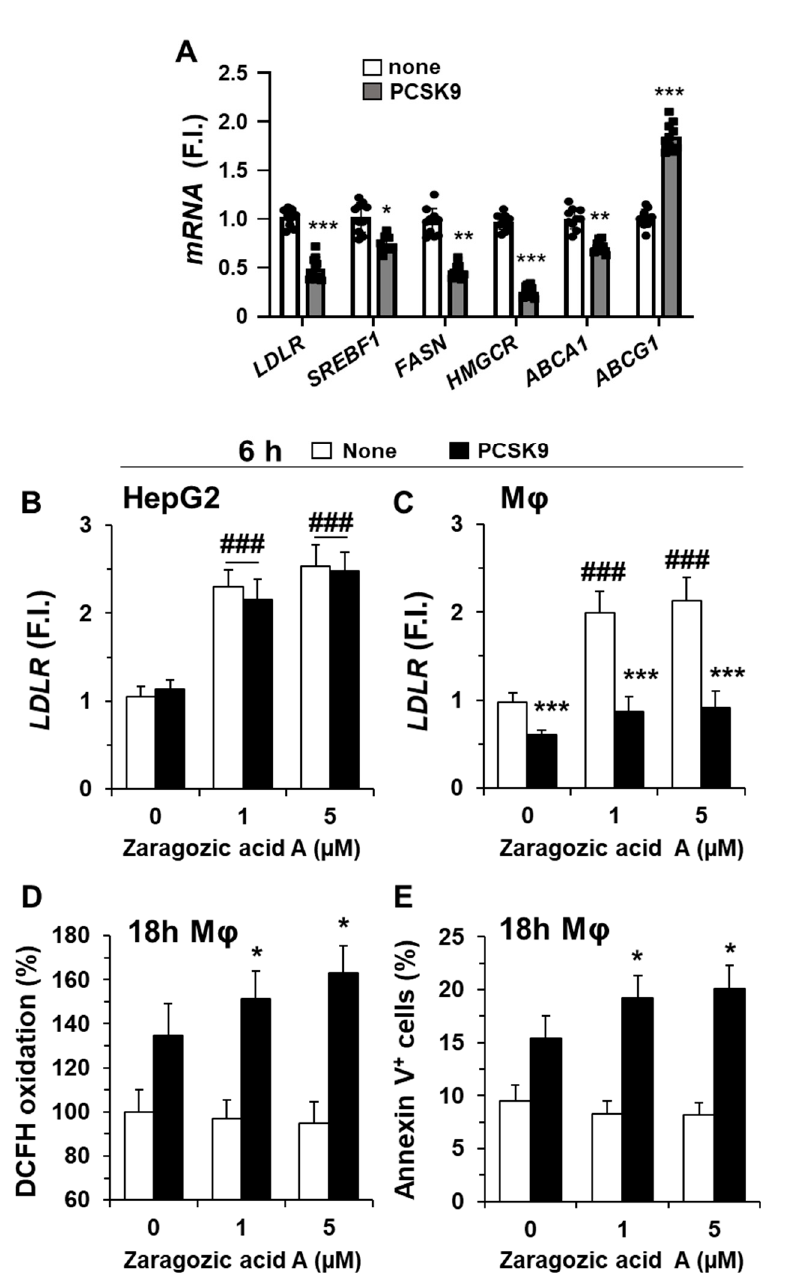
Figure 3. Incubation of human macrophages with PCSK9 reduces the expression of genes involved in lipid and cholesterol metabolism. ( A ) Quantification of LDLR, SREBF1, FASN, HMGCR, ABCA1 , and ABCG1 mRNA levels in hM φ after treatment with 0.5 µg/mL of PCSK9. Graphs represent the mean ± SD as the fold induction (F.I.) of each experimental group using RPLP0 ( 36B4 ) expression as endogenous control. ( B , C ) HepG2 cells and hM φ were incubated for 24 h with the indicated concentrations of zaragozic acid A, followed by the addition of 0.5 µg/mL of PCSK9, and the LDLR mRNA levels were quantified. ( D , E ) The synthesis of ROS and the quantification of annexin V + cells were determined after 18 h of incubation with PCSK9 in hM φ treated as described in panel C. Data show the mean ± SD of 6 independent donors ( A ) or from 4 independent experiments ( B – E ). * p < 0.05, ** p < 0.01, and *** p < 0.001 vs. the corresponding condition in the absence of PCSK9; ### p < 0.001 vs. the corresponding condition in the absence of zaragozic acid A.